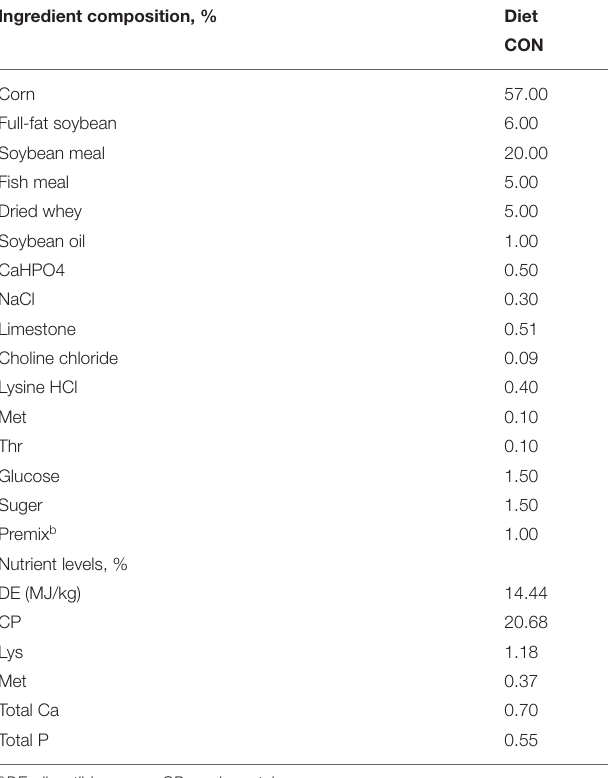
TABLE 1 | Composition and nutrient levels of diets a